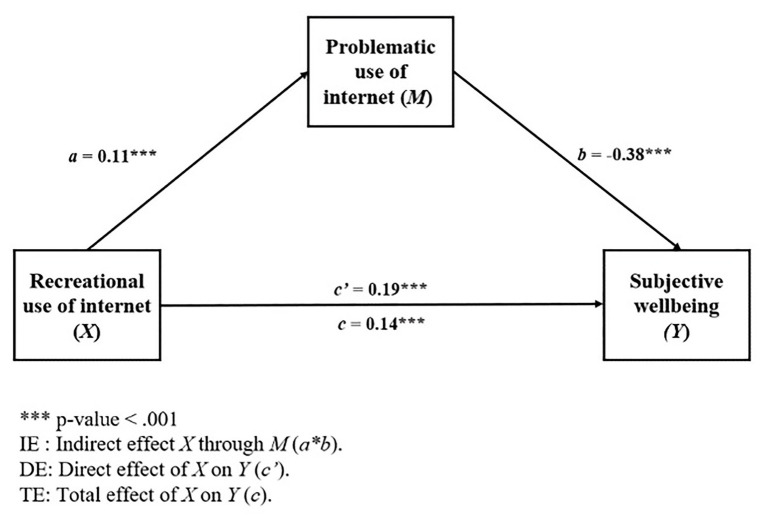
Mediational model 2.